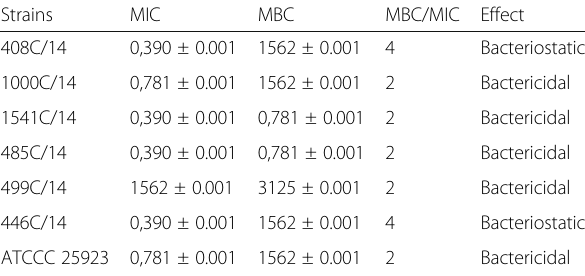
Tieghemella heckelii on Methicillin-resistant and reference strains of Staphylococcus